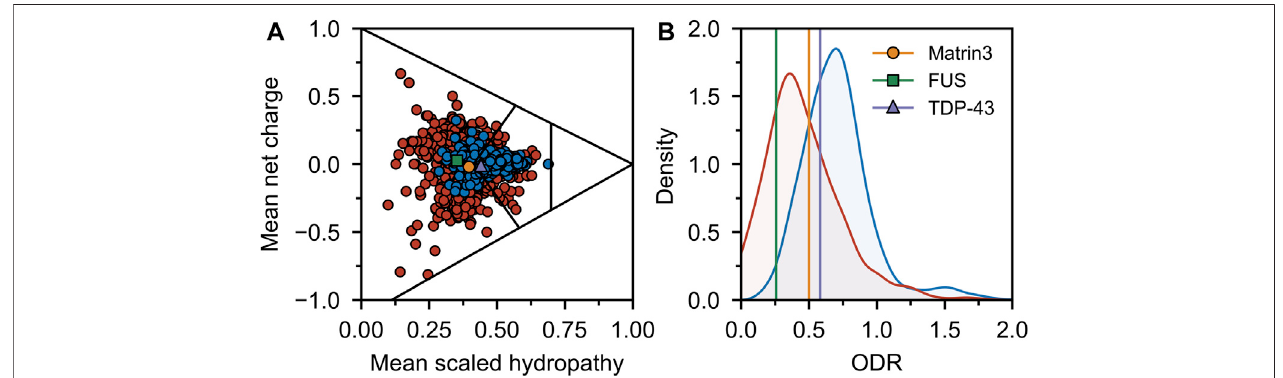
FIGURE4 | Sequence disorder analysis. (A) Charge-hydropathy plot. The plot isbased on the method introduced by Uversky et al. (Uversky et al.,2000; Uversky, 2017) and compares the mean net charge and mean Kyte-Doolittle hydropathy (Kyte and Doolittle, 1982) (scaled between 0 and 1). Linear boundaries are used to separate various groups of proteins (from left to right extended IDPs, compact soluble proteins, and insoluble proteins). A random sample of ordered (blue) and disordered (red) proteins was taken from the Swiss-Prot (The UniProt Consortium, 2018) and Disprot 7.0 (Piovesan et al., 2016) databases respectively and plotted. Matrin3, FUS and TDP-43 are indicated. (B) ODR ratio distribution plot. The same sample as in (A) was used to compute the ratio of the order-promoting to disorder-promoting residues with value truncation at 0 and 2. Disordered proteins (red) show a lower ratio (i.e., more disorderpromoting) than ordered proteins (blue).